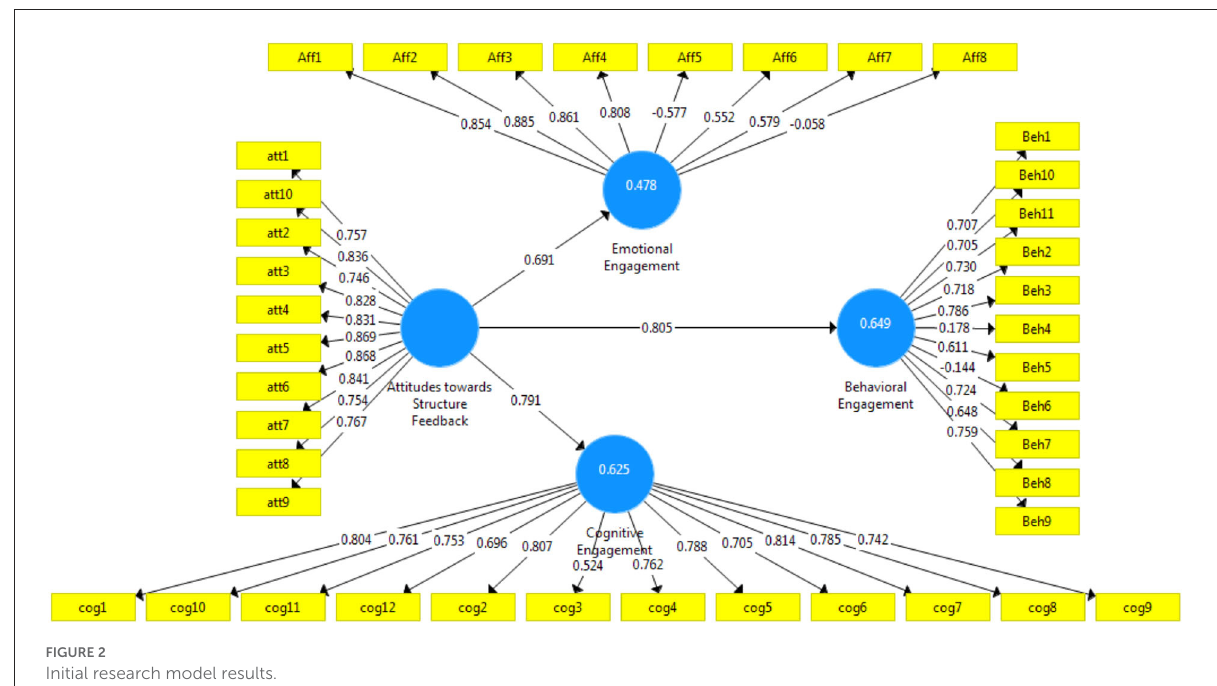
FIGURE2 Initial research model